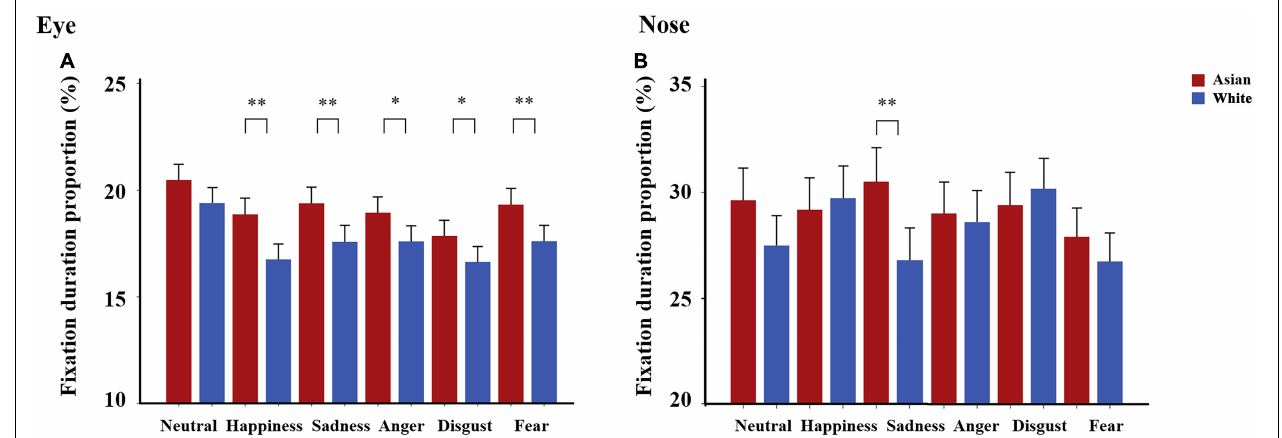
FIGURE 3 | Differences in fixation duration proportion (%) of Asian and White facial expressions. Fixation duration proportions for each facial expression between Asian and White for (A) eye and (B) nose were shown. Bars represent mean fixation duration proportion across trials. Error bars represent standard errors of the means. ∗ p < 0.05, ∗∗ p < 0.01 for Asian vs.